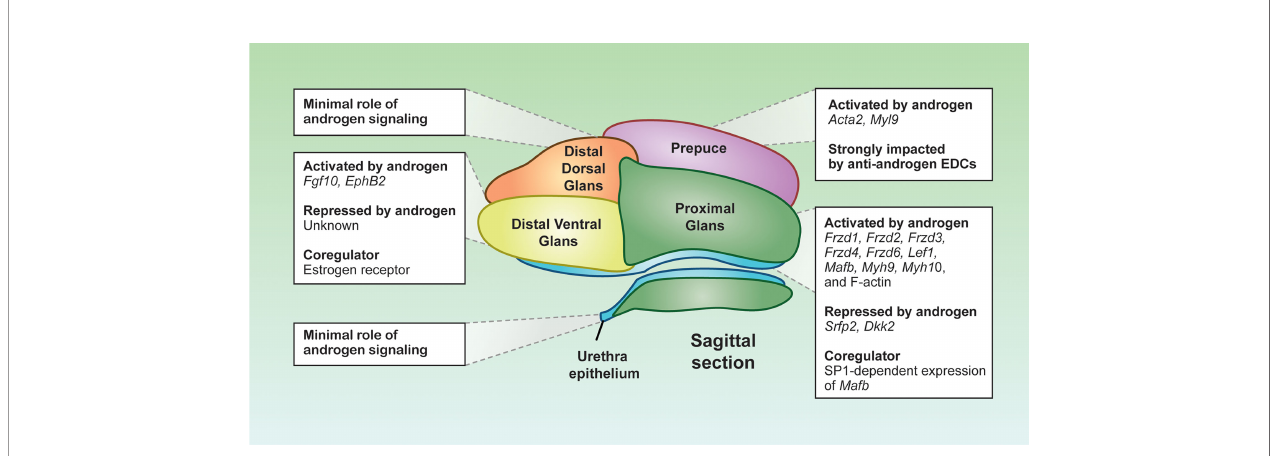
FIGURE 3 | Distinct androgen responsiveness of the penile cell populations. Representative sagittal section depiction of an E16.5 mouse penis. Each color represents a distinct cell population, displaying the localization of the cell populations in the penis. Boxes are the androgen-related programs for each subpopulation. Depiction was generated from sagittal sections of mouse penises generated in the Yao